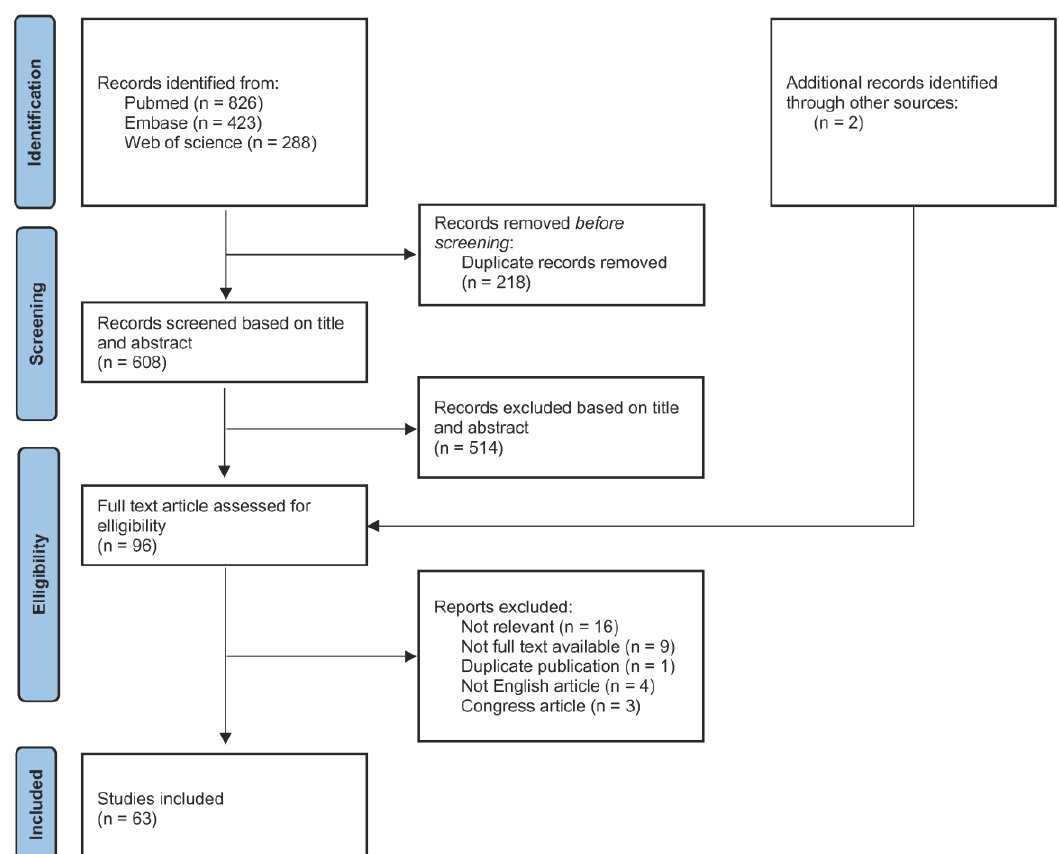
Figure 1. PRISMA-ScR flowchart of study selection process.